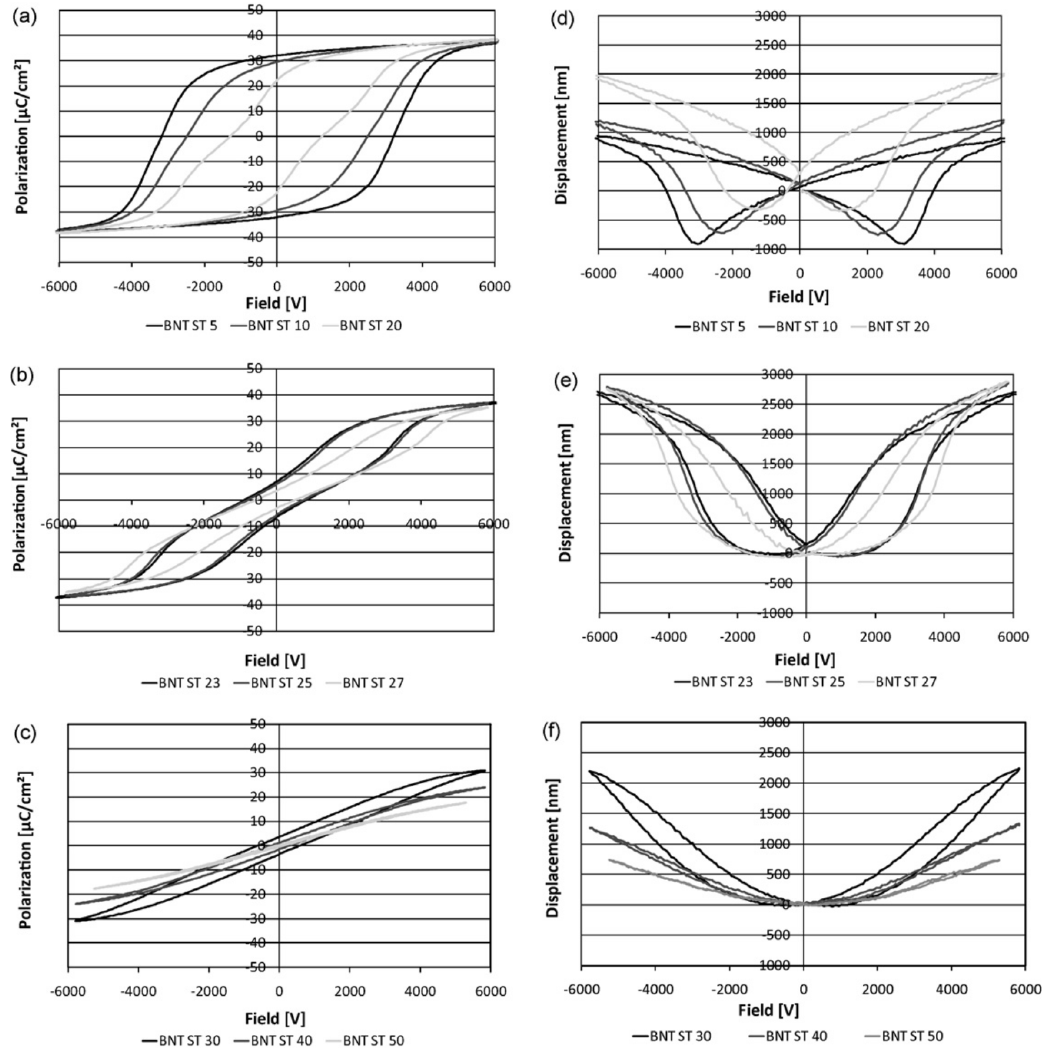
Figure 6. Polarization and displacement curves for the system (100 − x )(Bi 0.5 Na 0.5 )TiO 3 – x SrTiO3 (x = 5, 10, 20 ( a,d ), x = 23, 25, 27 ( b,e ), x = 30, 40, 50 ( c,f ), reprinted from reference [109] with copyright from Elsevier 2010).